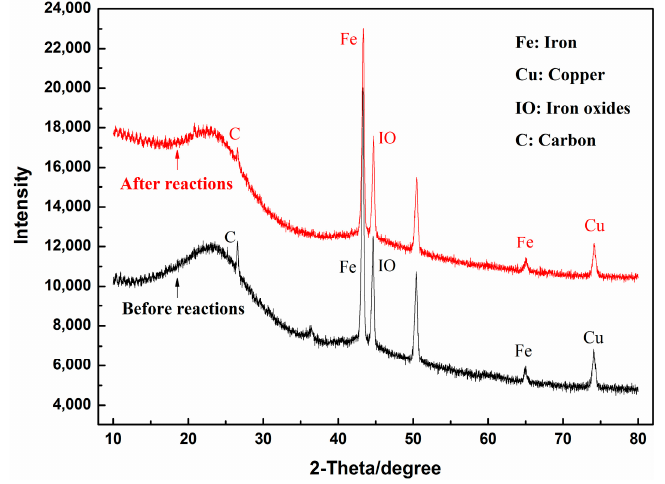
Figure 3. X-ray Diffraction (XRD) images of the Fe-Cu/biochar system.